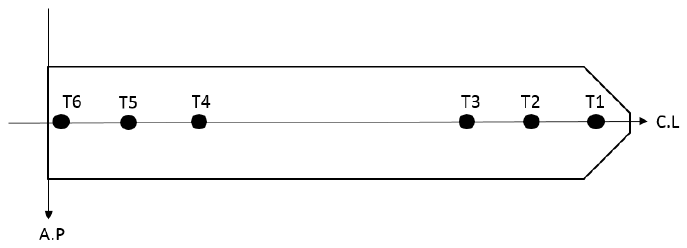
Figure 18. Single-Alignment Configuration.